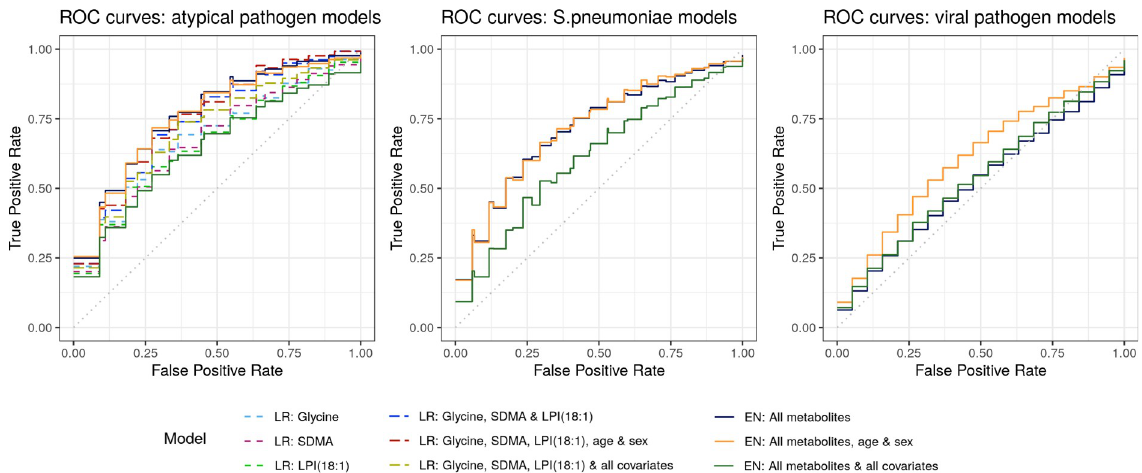
Fig 3. ROC curves of the results from logistic regression and elastic net regression models that were tested in five-fold cross-validation with 100 repeats for the comparisons: atypical versus S. pneumoniae and viral pathogens; S. pneumoniae pathogens versus atypical and viral pathogens; and viral versus S. pneumoniae and atypical pathogens. Abbreviations: LR: logistic regression, EN: elastic net regression, SDMA: symmetric dimethylarginine, LPI (18:1): lysophosphatidylinositol (18:1).